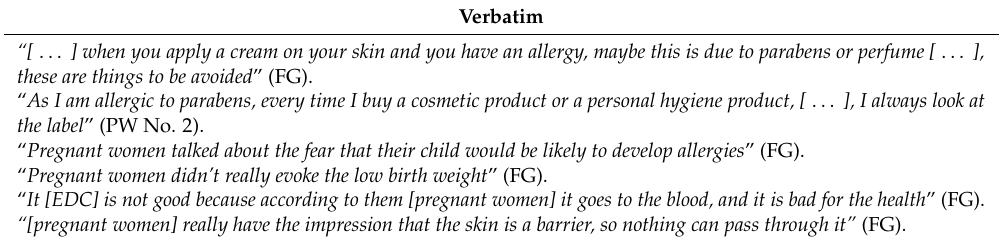
Table 2. Relevant extracts of verbatim obtained in the qualitative study defining EDC risk perception. Verbatim